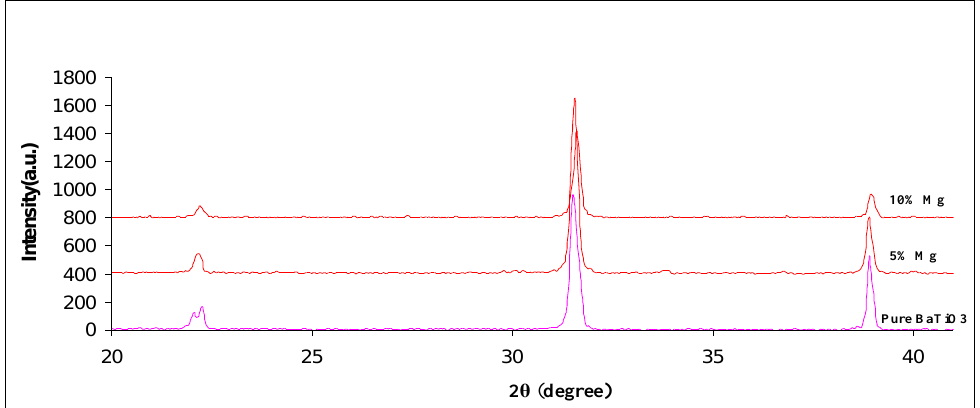
Fig. 11: The shifted of the first three peaks of (BMT) at 1400 ° C.